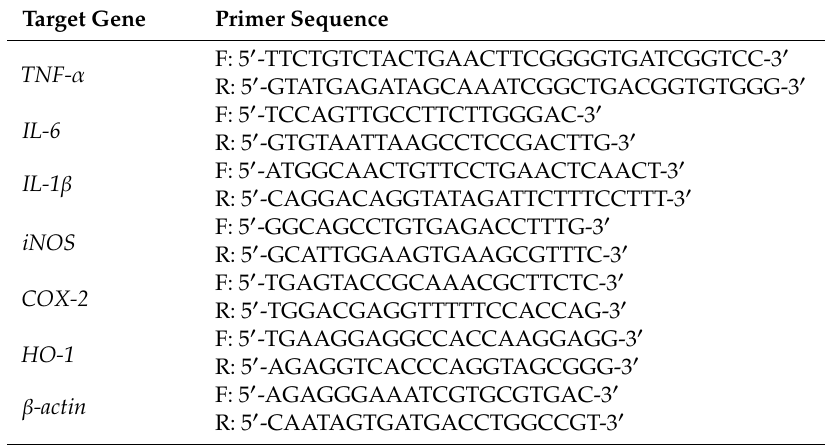
Table 2. Primers used for real-time reverse transcription-polymerase chain reaction (real-time RT-PCR). Target